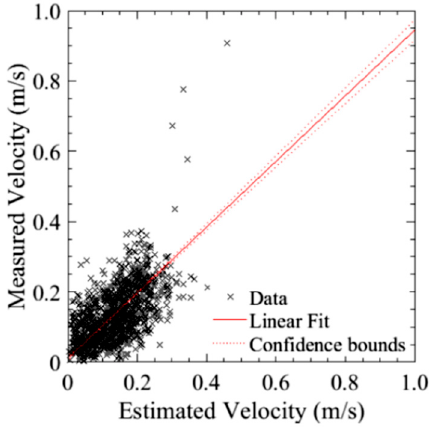
Figure 14. Estimated velocity (from GPS) versus measured velocity (DIC) of the best run for the S1000+.